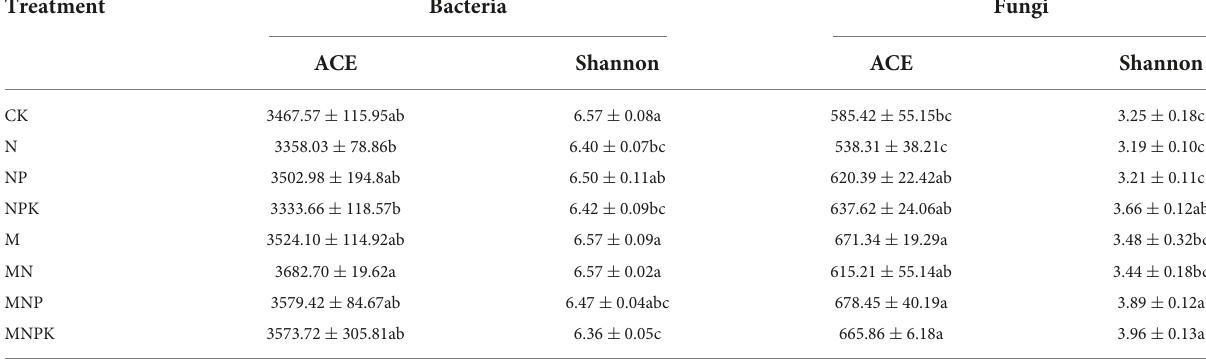
manurepluschemicalNandPfertilizer;MNPK,pigmanurepluschemicalN,P,andKfertilizer. TABLE 2 Soil microbial alpha-diversity indices for different